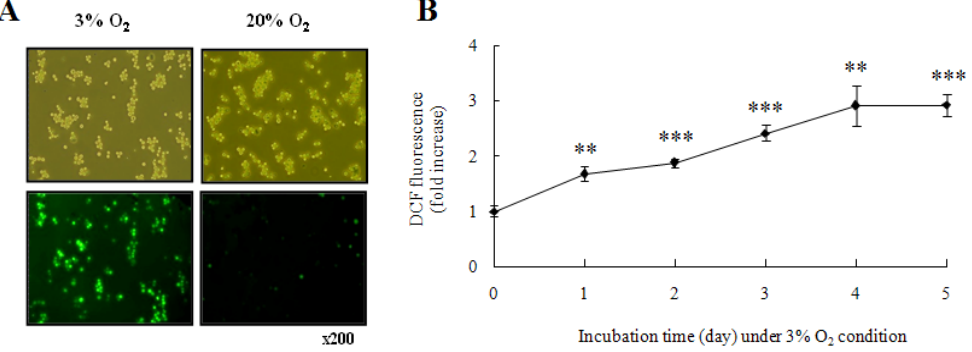
Figure 2. Hypoxia generated intracellular ROS in THP-1 cells. ( A ) Representative fluorescence microscopic images showing the fluorescence of DCF oxidized by intracellular ROS in THP-1 cells grown in 20% or 3% O for 5 days. After cultivation, the 2 cells were incubated with 10 μM DCFH-DA for 15 min at 37 °C and assessed by fluorescence microscopy; ( B ) Normalized mean fluorescence intensities (MFI) of DCF in THP-1 cells grown in 3% O for 1–5 days were examined by FACS analysis. 2